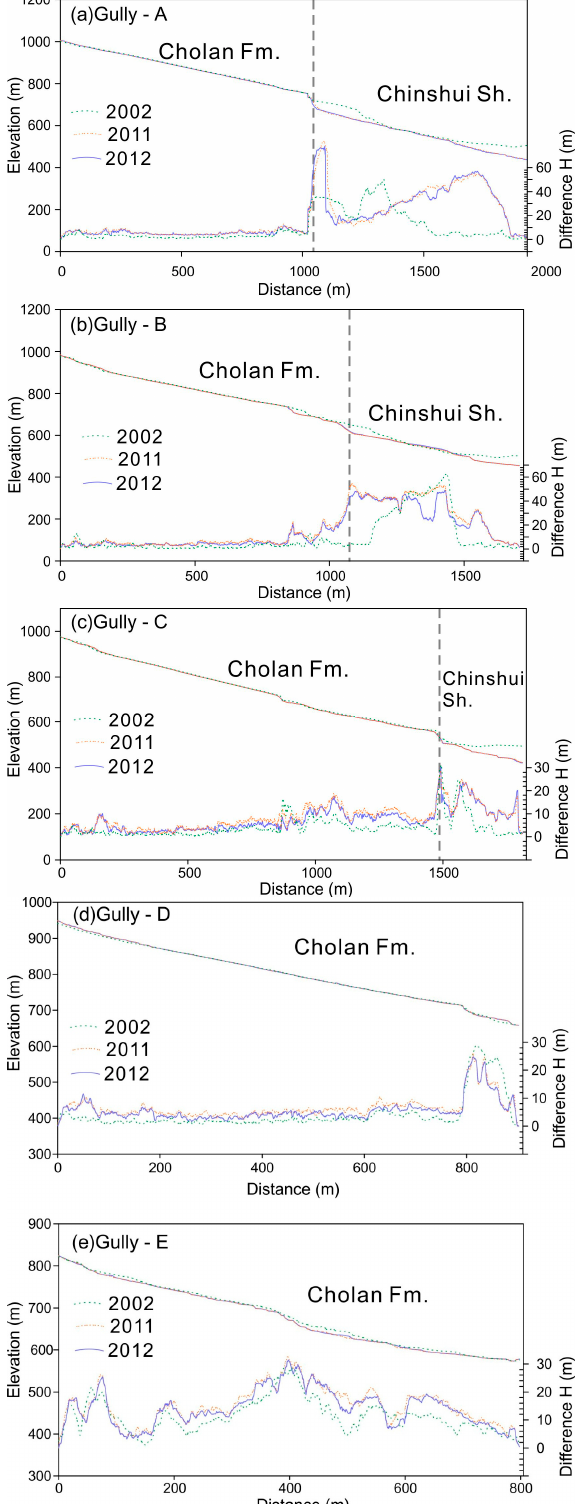
Figure 7. ( a – e ) Geomorphological profile and cross section elevation difference distribution calculated based on the three periods of ALS DEM data using the continuous swath profiles selection method. The former is drawn according to the lowest values of the continuous cross sections, while the latter is drawn by calculating the difference between the highest and lowest values of each cross section. The grey spotted line denotes the position of the Chunqiu Cliff, which is the boundary between the Cholan Formation and the Chinshui Shale.